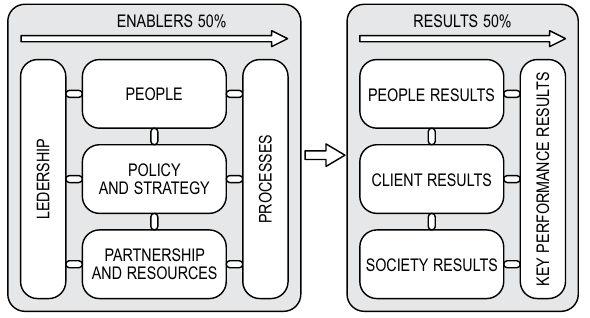
Fig. 3. The excellence model validated by the factor analysis